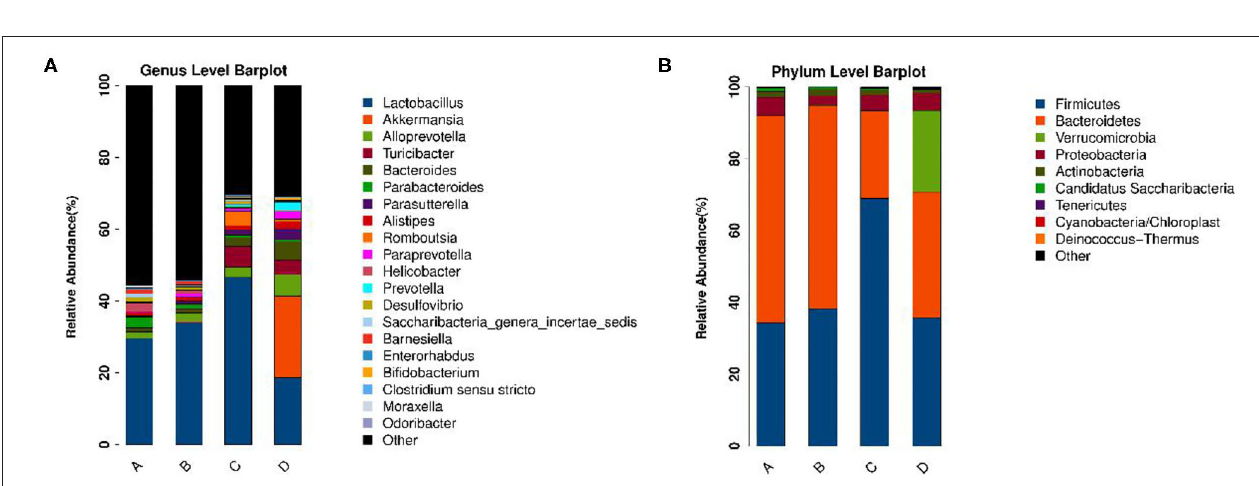
FIGURE 5 | The relative abundance of each microorganism in each group. (A) Genus level; (B) Phylum